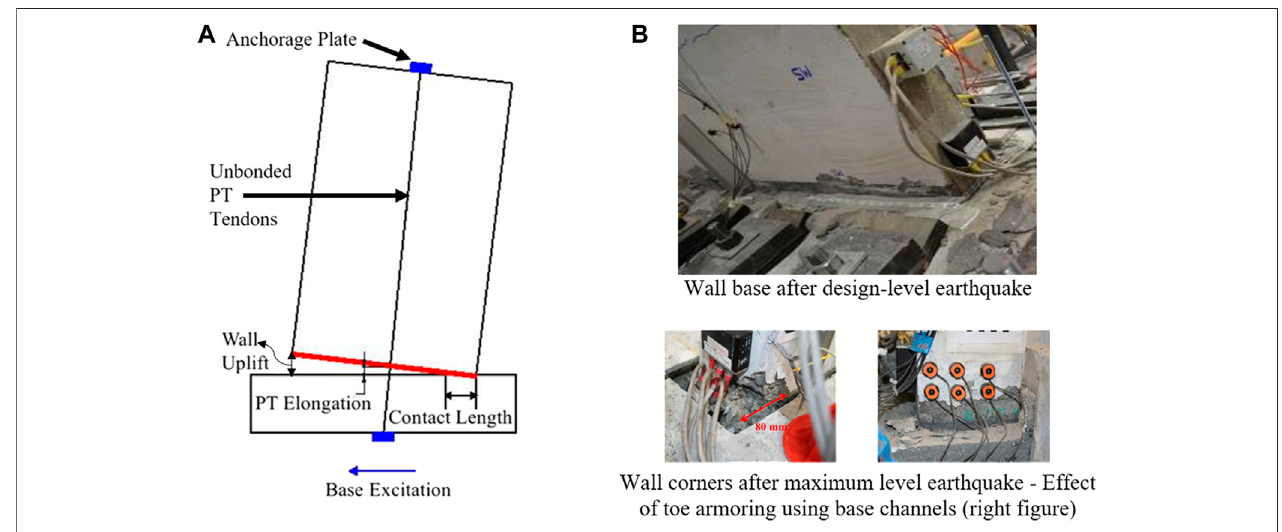
FIGURE 1 | Single rocking wall (SRW) (Nazari et al., 2017): (A) System setup; (B) Damage status after earthquakes.